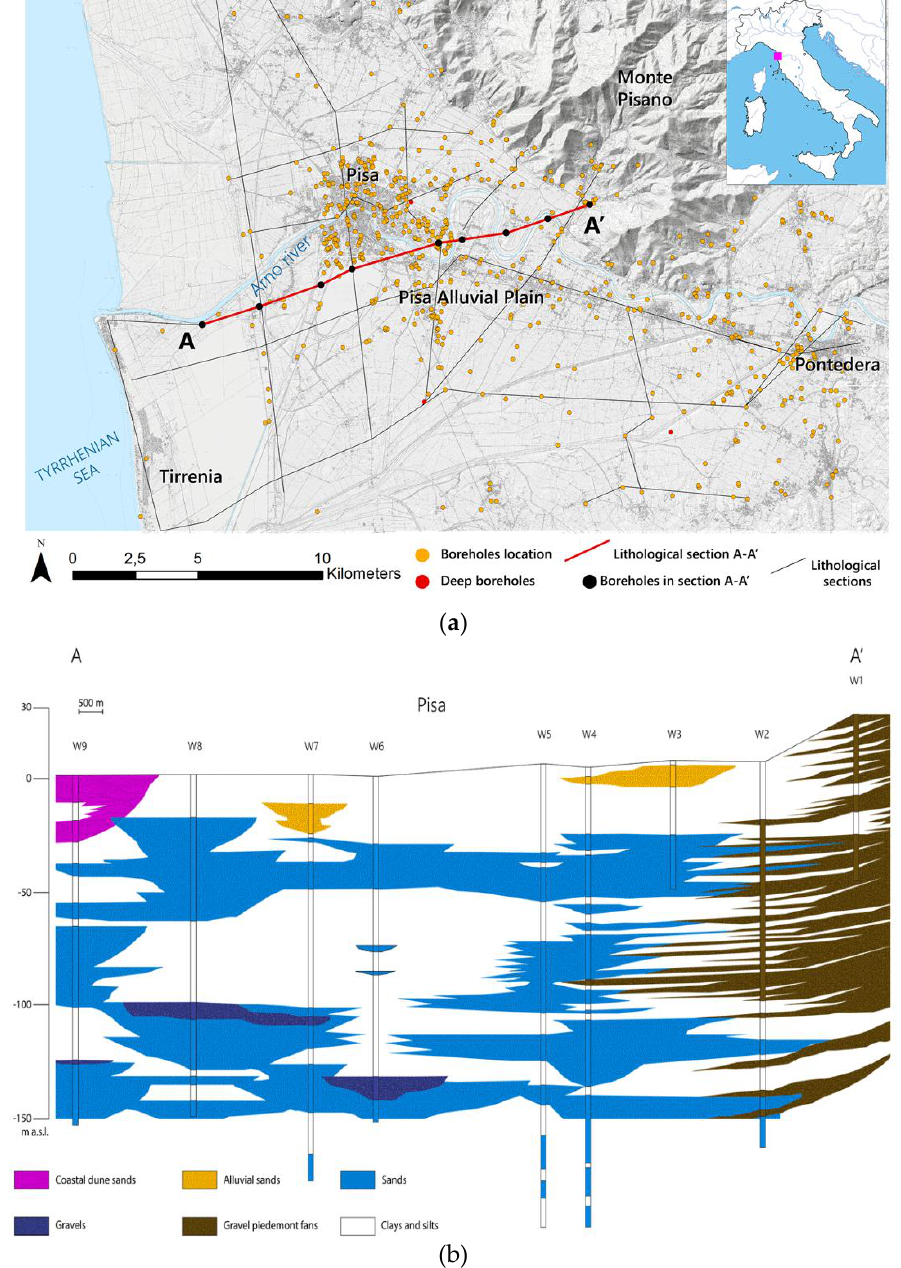
Figure 2. ( a ) 2D map with boreholes imported into the geodatabase. Coordinate system: WGS_1984_UTM_Zone_32N (EPSG 32632); ( b ) Example of a lithological section.